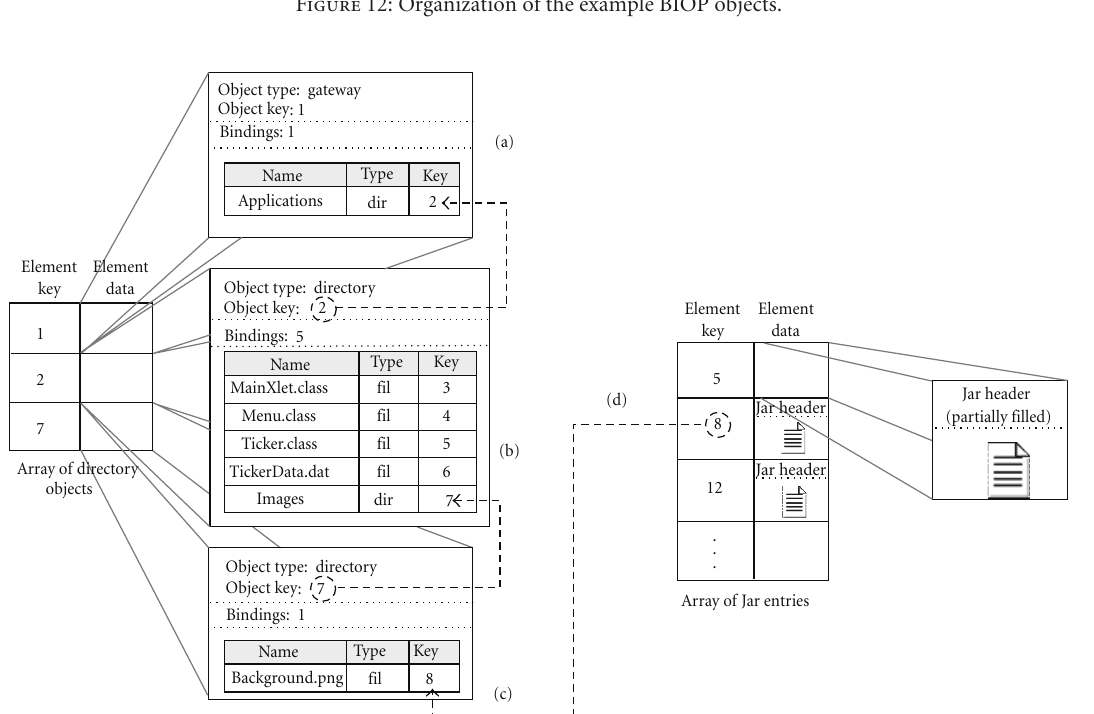
Figure 13: Arrays of jar entries and directory objects, with the route for tracing the filename for a jar